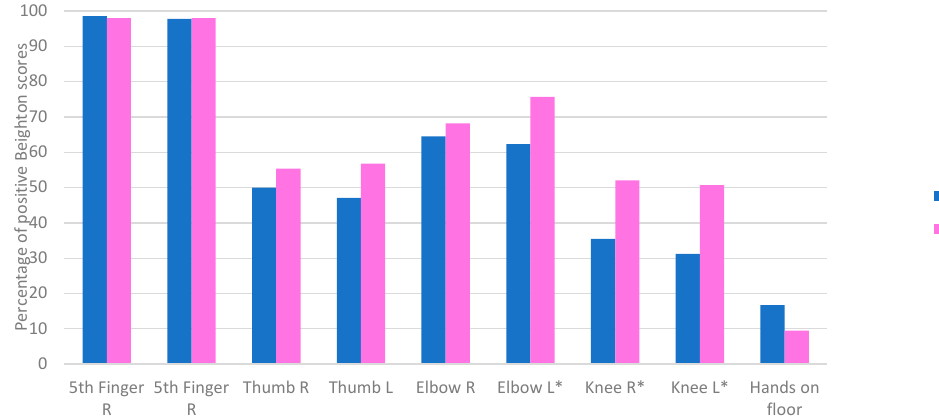
Figure 3. Percentage of positive Beighton scores for boys and girls per item. * indicates signi fi cant di ff erences.